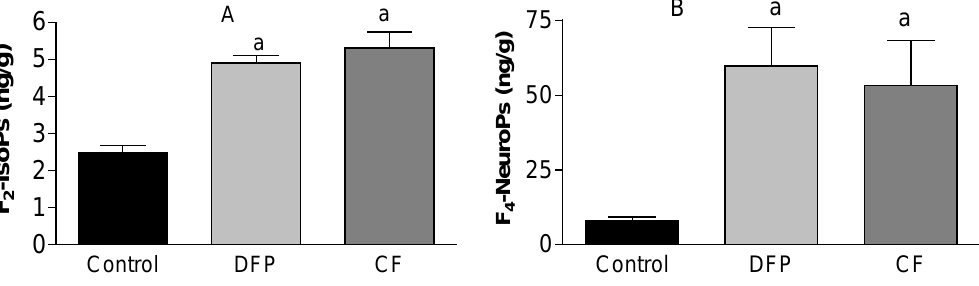
FIGURE 5 . Effect of DFP (1.5 mg/kg, s.c.) or CF (1.5 mg/kg, s.c.) on (A) F 2 -IsoPs and (B) F 4 -NeuroPs levels in rat brain. Values are mean ± SEM (n = 4–6). a Significant difference between control and DFP- or CF-treated rats ( p <